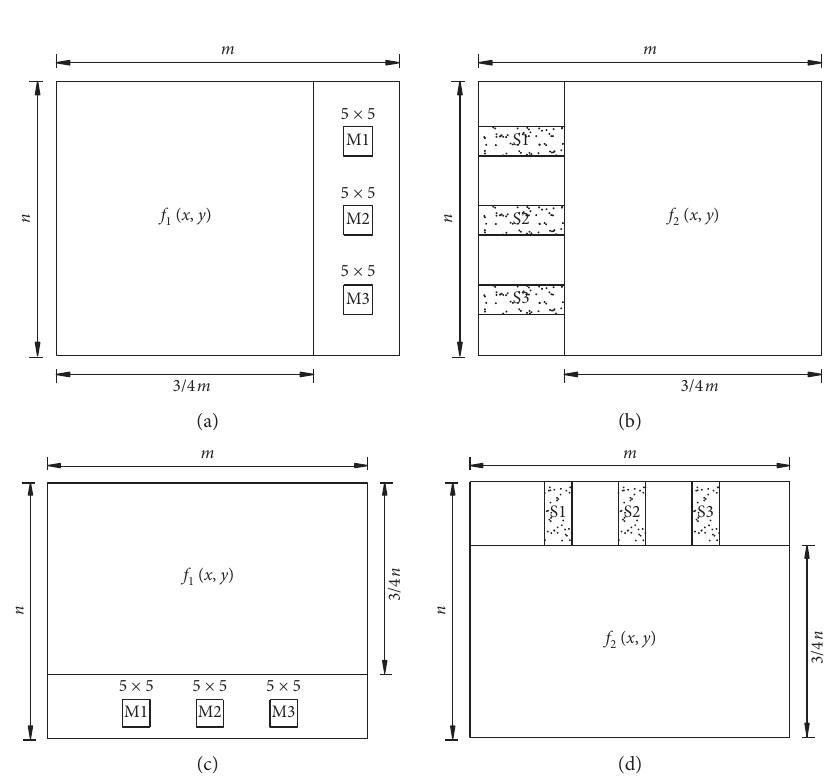
Figure 7: The schematic diagram of image mosaic: (a, b) image mosaic in left and right directions; (c, d) image mosaic in upper and lower